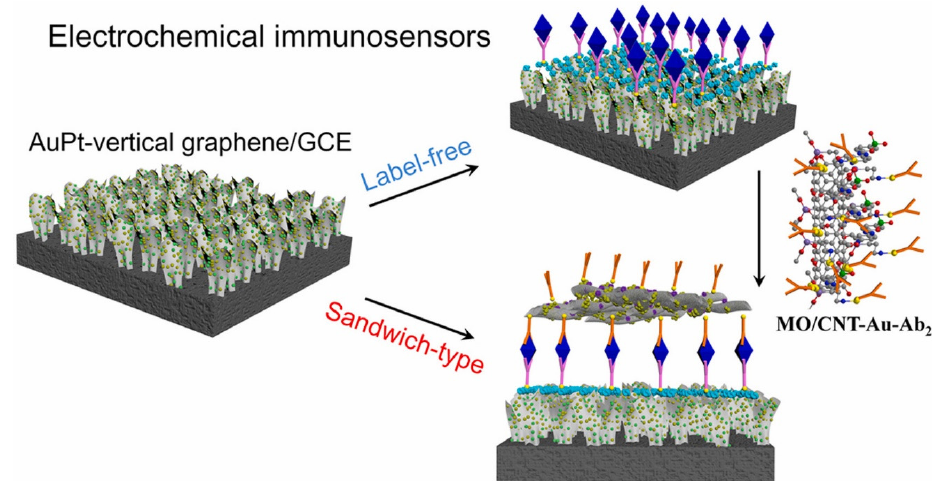
Figure 8. Schematic illustration of the development label-free and sandwiched-type approach for AuPt-VG/GCE-based bioelectronic interfaces for the detection of liver cancer marker i.e., alpha-fetoprotein [45].